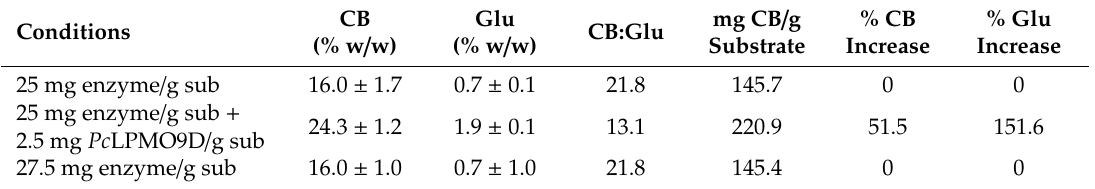
Table 3. Evaluation of synergistic effect of Celluclast ® supplementation with Pc LPMO9D towards the production of cellobiose.